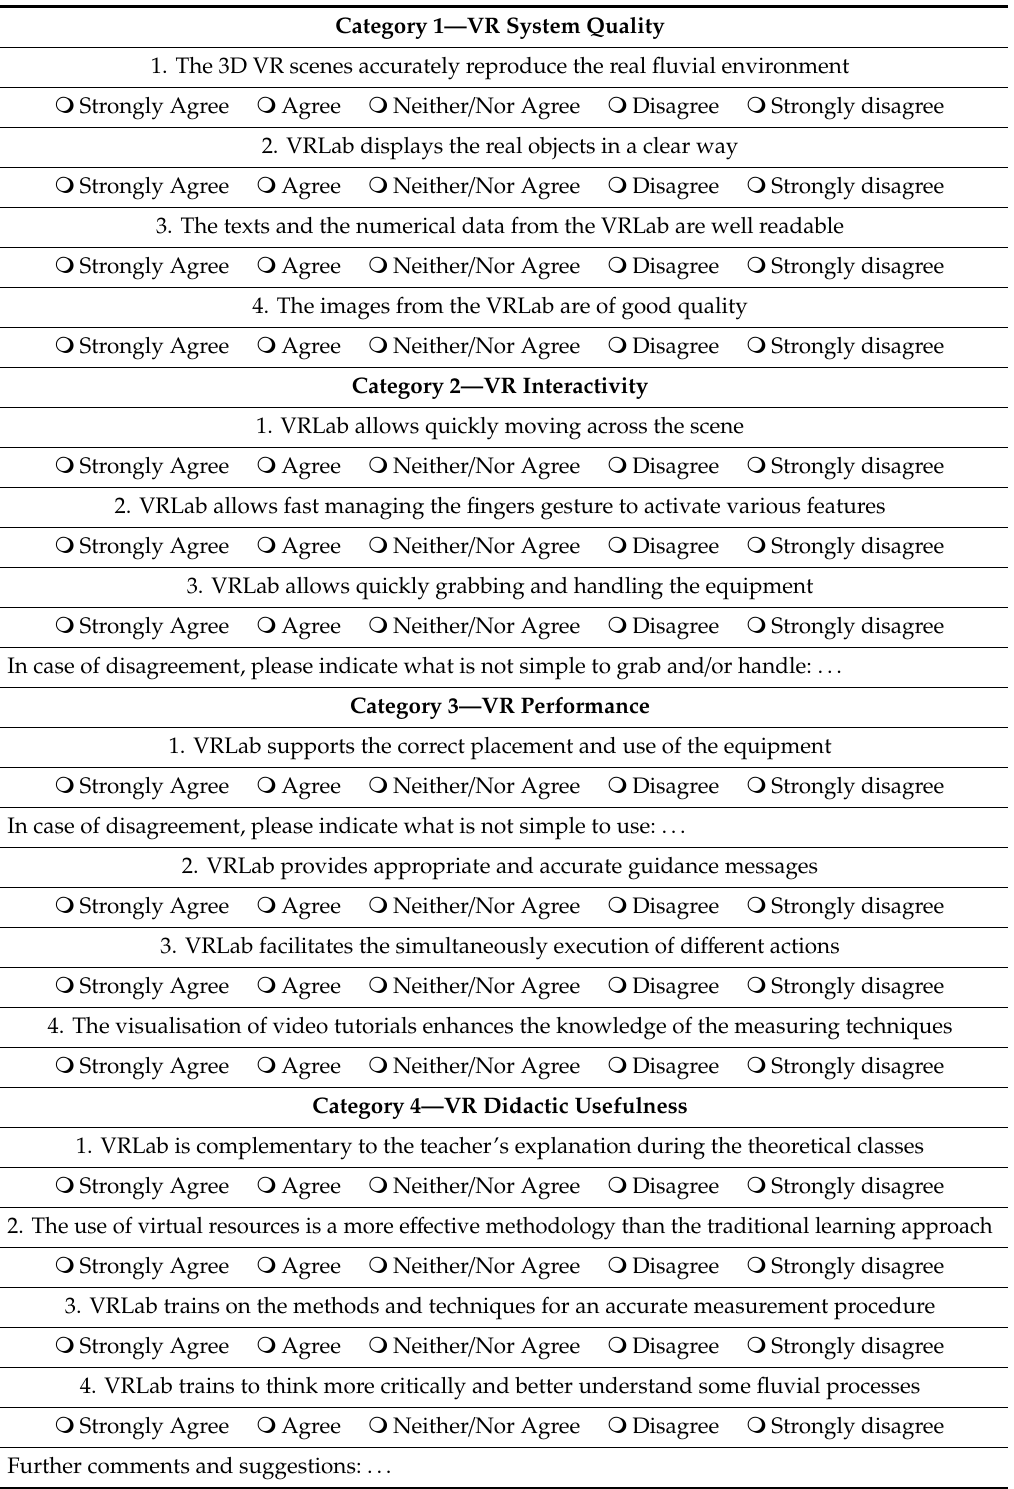
Table 2. Values of mean, μ , and standard deviation, σ, based on the scores obtained from the questionnaire.